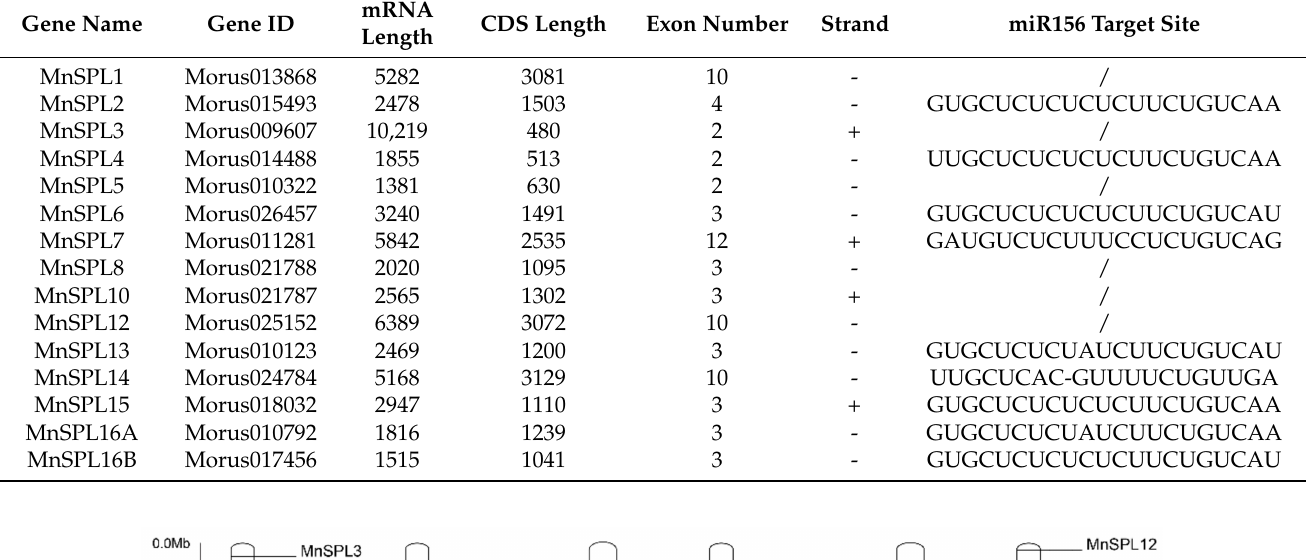
Table 1. Gene ID and gene structures of SPLs in mulberry. The gene ID of MnSPLs were obtained from the Morus Genome Database (MorusDB) (https://morus.swu.edu.cn/, accessed on 3 March 2020).